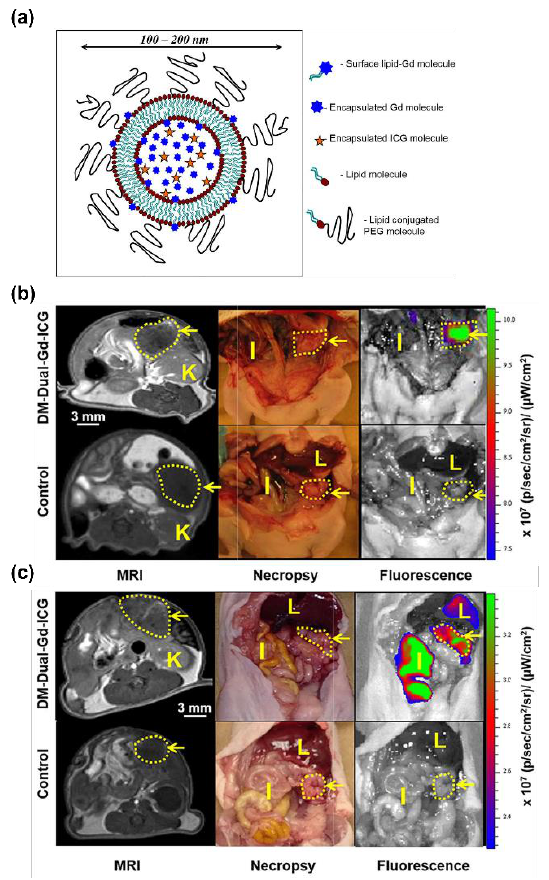
Figure 7. Dual-mode dual-gadolinium-ICG < 200 nm liposomal nanoparticles for MRI and NIR imaging of orthotopic ovarian tumors by Ravoori et al. [146]. ( a ) Schematic diagram of the dual-Gd ICG liposomes consisting of encapsulated Gd and ICG in a lipid bilayer with additional surface bound Gd molecules and a low-fouling PEG molecule. Representative axial MRI (live) and optical (coronal necropsy) imaging of nude mice 2 days post IV injection of the liposomal contrast agent for mice bearing orthotopic OVCAR-3 ( b ) and HeyA8 ( c ) tumors. Arrow, tumor; I, intestine; K, Kidney; L,